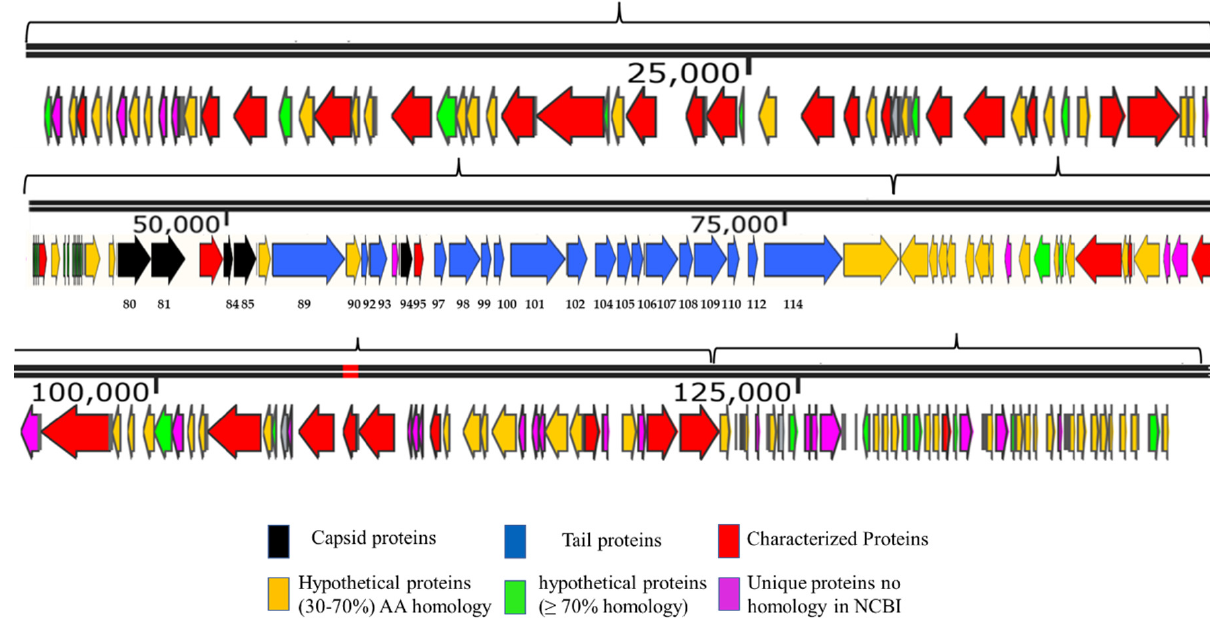
Figure 3. Genome map of SSBI34 (141.095 Kb). The directions of arrows represent the replication strands (+ or − ). Different ORFs are color-coded to reflect their characteristics. ORFs having BLASTp homology with characterized phage proteins in NCBI are colored red. Black ORFs are involved in the capsid head formation, blue ORFs are involved in tail formation, orange ORFs are hypothetical proteins having BLASTp homology of between 30 and 70%, whereas Green ORFs are hypothetical proteins with BLASTp homology of between 70 and 90%. Purple ORFs have no significant homology with any protein in NCBI or BLASTp and are unique to SSBI34. The upper line represents the scale bar. Numbers at the bases of ORFs represent ORF numbers corresponding to structural proteins given in Table 2, whereas all other protein homologs are given in Supplementary Table S2.